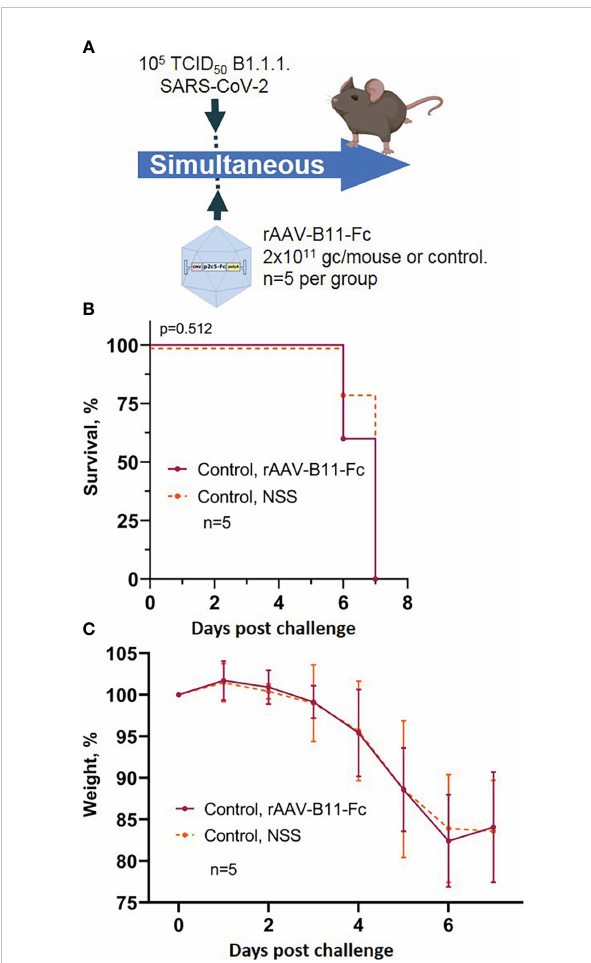
FIGURE 4 Evaluation of non-speci fi c protective activity of rAAV against SARS- CoV-2 infection. (A) Scheme of the experiment: brie fl y, mice were infected with 10 5 TCID50 SARS-CoV-2 B.1.1.1 and simultaneous treated with 2*10 11 gc/mouse of rAAV-B11-Fc. (B) Animal survival. (C) Body weight loss. Lines – mean values, error bars – SD, numbers indicate statistical signi fi cance evaluated compared with the vehicle group using a logrank test. Data from different treatment groups are shown by color. Control, NSS – mice received normal saline solution. n – number of animals per